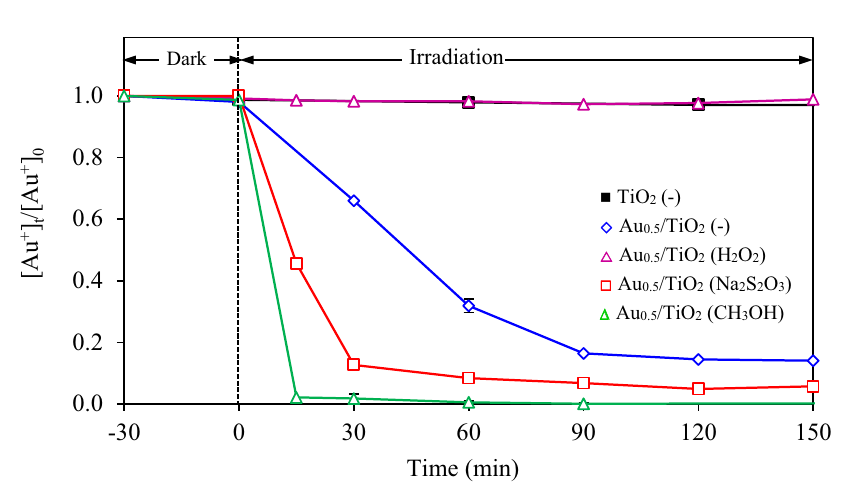
Figure 10. Variation of gold recovery via Au 0.5 /TiO 2 photocatalyst at dosage of 2 g/L and light intensity of 3.20 mW/cm 2 in the presence of different hole